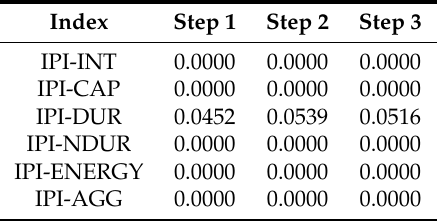
Table 19. Modified Diebold–Mariano statistics for equality of forecast accuracy of two forecasts under general assumptions with an expanding window from 2008:01 to 2018:12. The null hypothesis is that the two methods have the same forecast accuracy. The loss function is the absolute error.